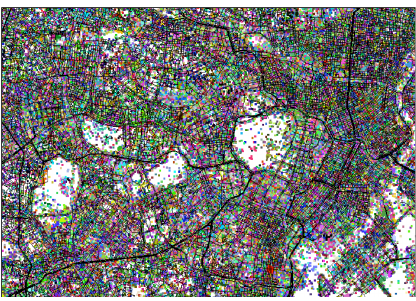
Figure 7. DRM road network in the Tokyo and Shinjuku Area